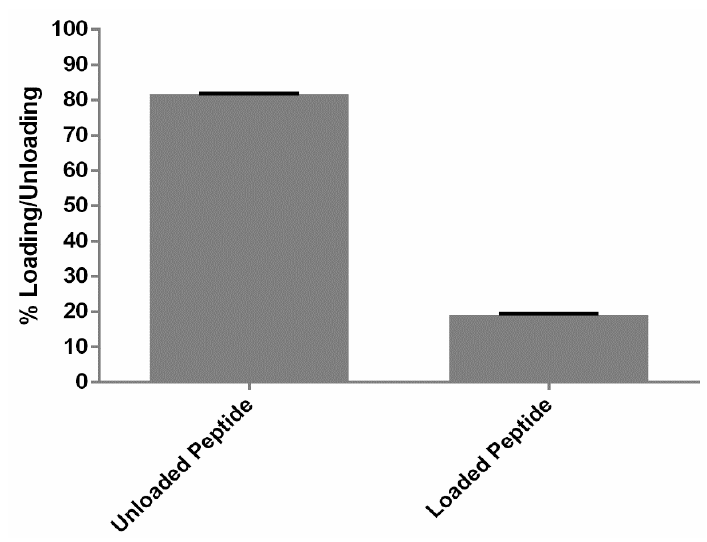
Figure 3. Liposomal loading with peptide RF-482 determined by the bicinchoninic acid (BCA) assay. Results presented as peptide loading determined after separation of the unloaded peptide ( n = 3 ± standard deviation (SD)).